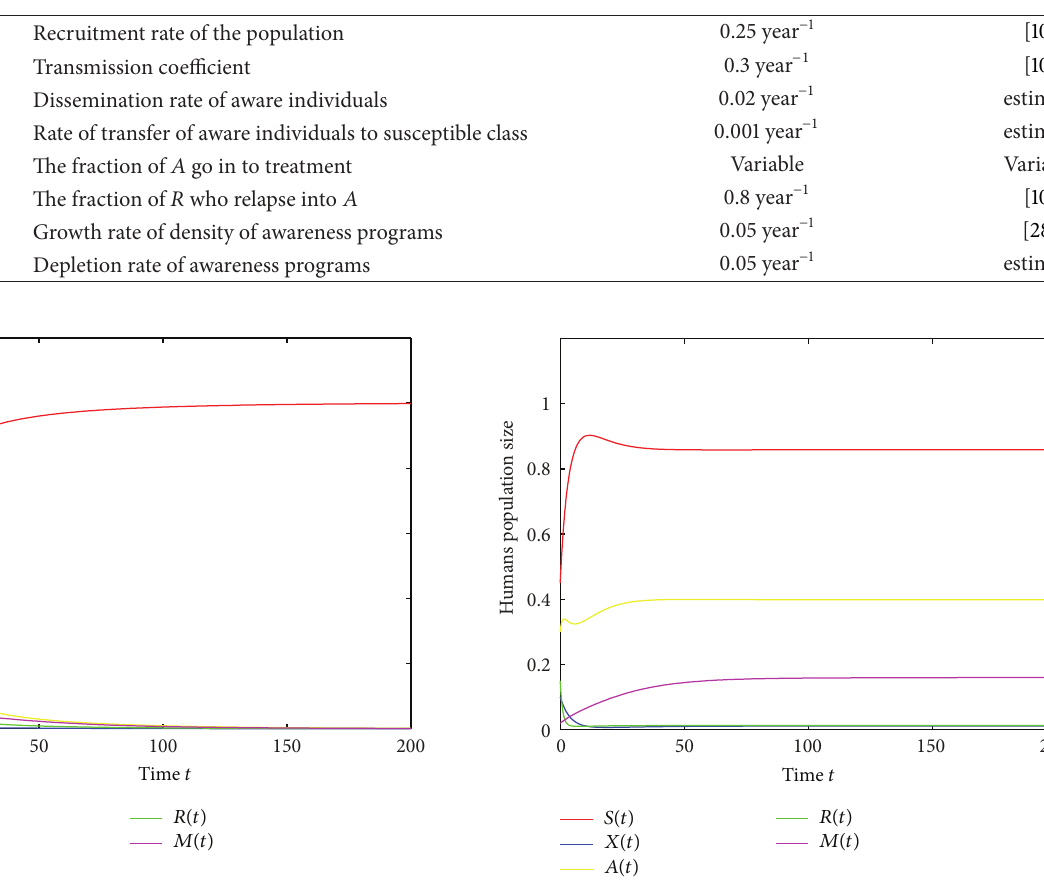
Figure 2: If 𝑅 0 < 1 , the alcohol free equilibrium 𝐸 0 is globally asymptotically stable.